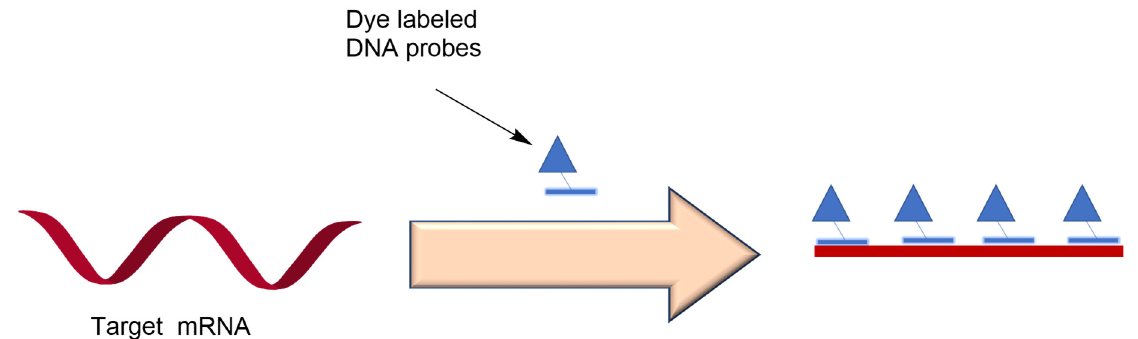
Figure 1. Hybridization scheme of single molecule FISH (smFISH).